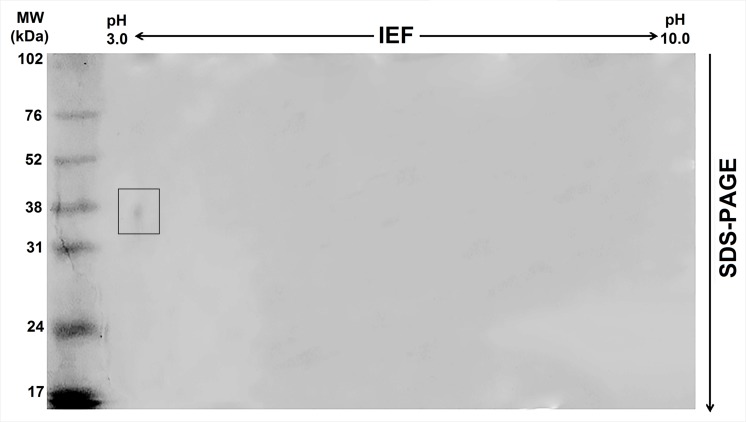
Two-dimensional electrophoresis of the trypsin inhibitor from leaves of T. stans (TesTI). A single spot, corresponding to a relative molecular mass of 39.8 kDa and a pI of 3.41, was detected. The gel was stained with Coomassie Brilliant Blue.